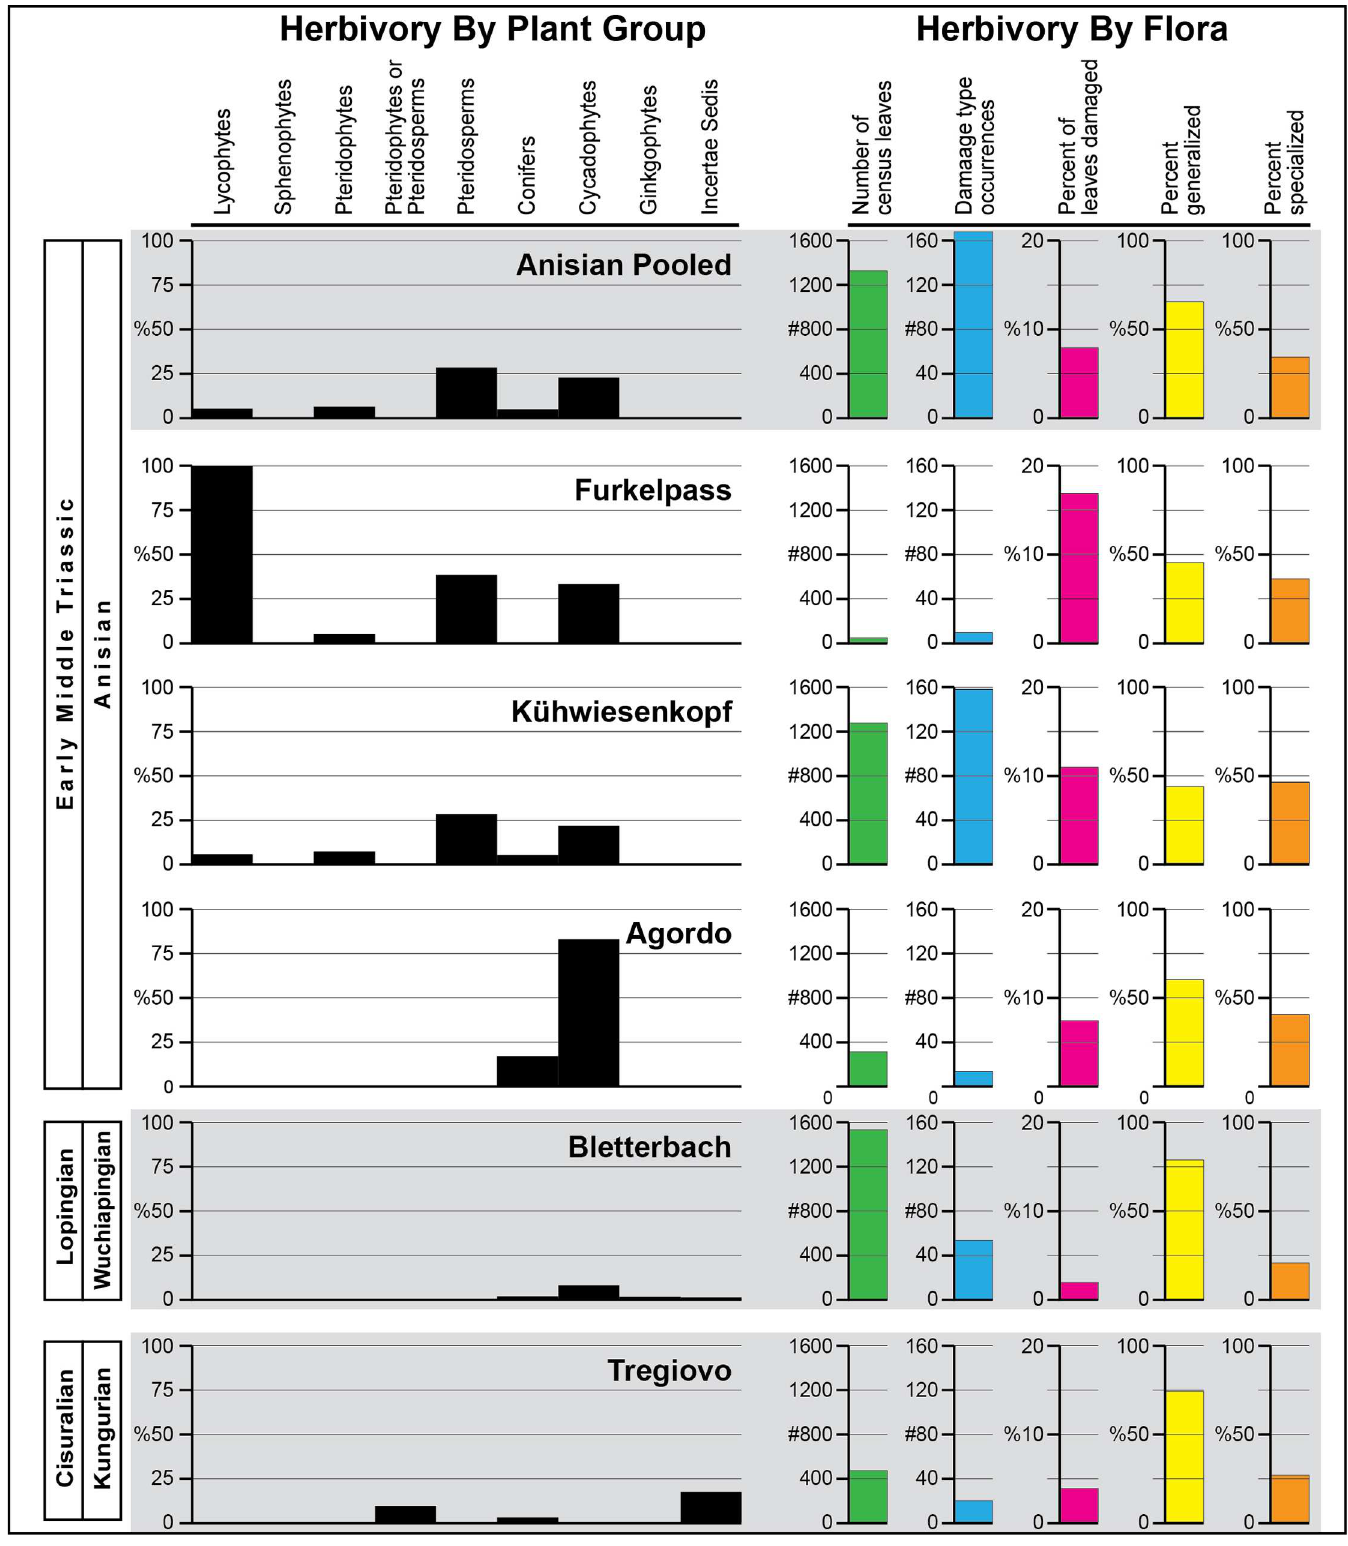
Fig 2. Quantitative distribution of plant–insect interactions from Cisuralian to Anisian strata in northeastern Italy.